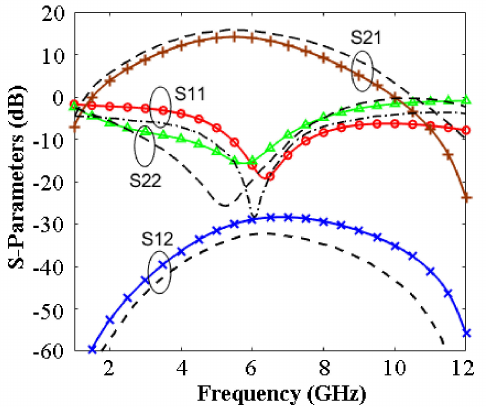
Figure 6. Simulated (black dotted) and measured (colored solid) traces of S-parameters for the fabricated PA.